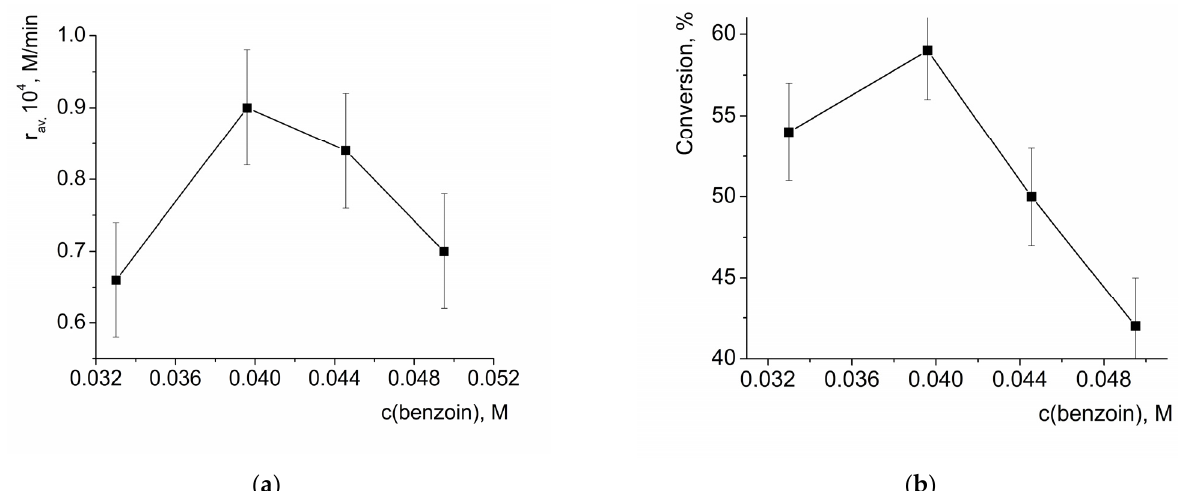
Figure 7. Dependency of the average initial reaction rate of benzoin oxidation by H 2 O 2 ( a ) and benzoin conversion after 3 h of reaction ( b ) on the initial concentration of benzoin. c eff. (HKUST-1) = 0.001 M, c(H 2 O 2 ) = 3.3 M.